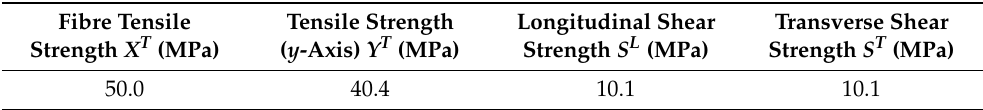
Table 10. Strength of auxetic fabric.